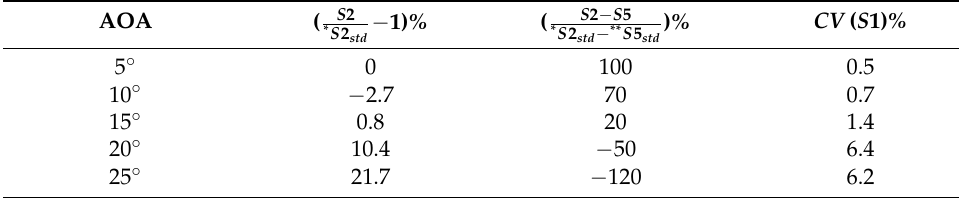
Table 4. Stall monitoring parameters at 9 m/s and an angle of attack between 5 ◦ and 25 ◦ .